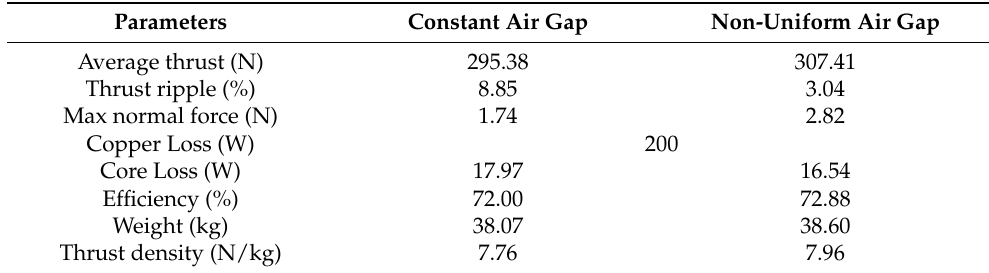
constant ones, and the reduction percentage is consistent with the detent force. Table 5. Key Parameters of DCB-VRLM with Non-uniform Air Gap Structure. Table 5. Key Parameters of DCB ‐ VRLM with Non ‐ uniform Air Gap Structure.